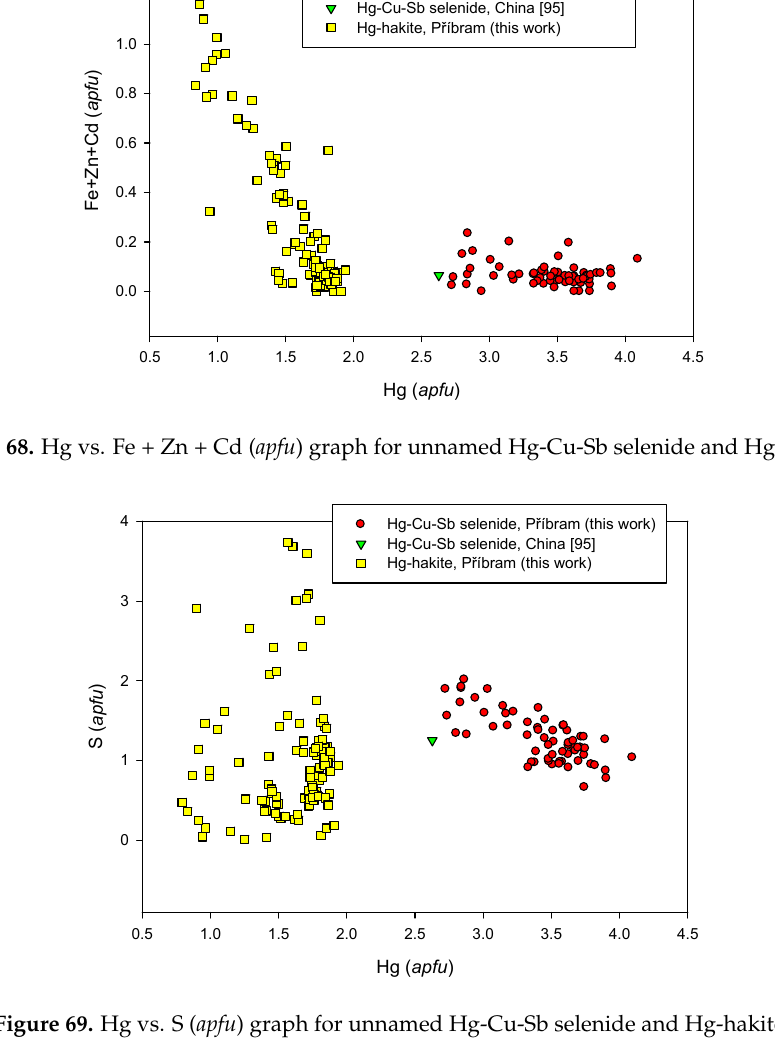
The empirical formula of a new Hg-Cu-Sb selenide (mean of 62 analyses) on the basis of (Sb +